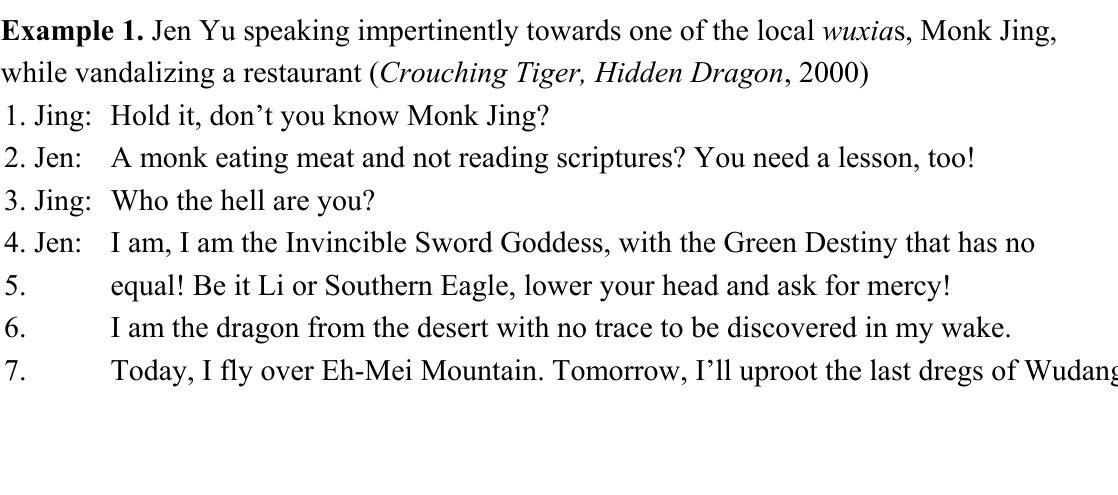
Flying Swords of Dragon Gate , 2011 © Distribution Workshop (HK). All Rights Reserved. Courtesy of Distribution Workshop (HK),